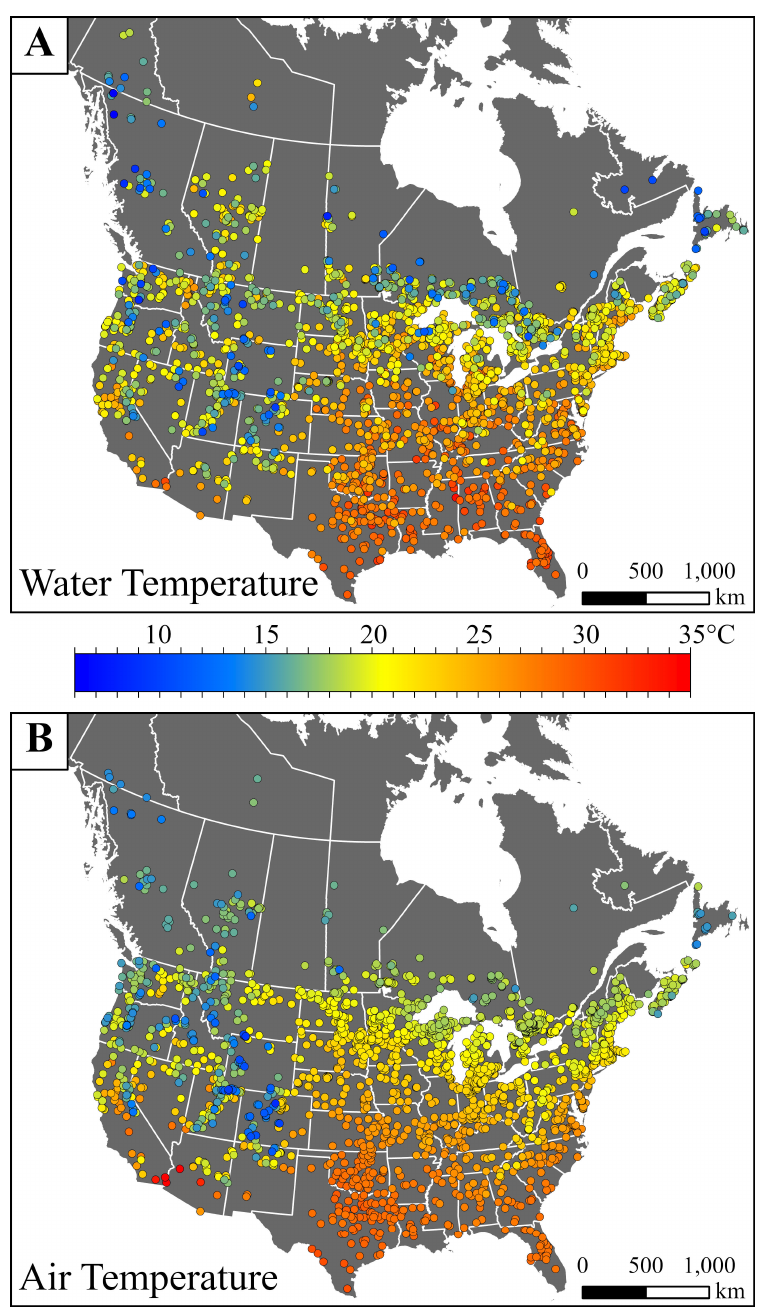
Figure 1. ( A ) Water temperatures measured at 1 m in in depth in lakes at some time in the months of June, July, August and September. ( B ) Average July air temperatures in the period 1981–2010 at stations near lakes with water temperature data. near lakes with water temperature